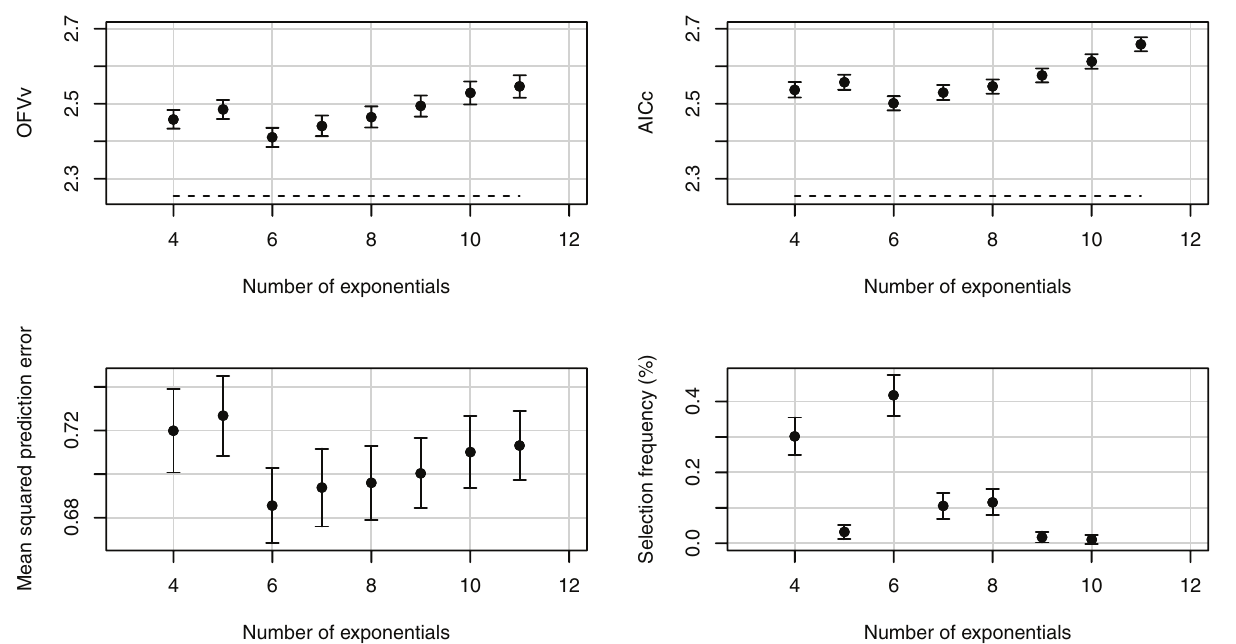
Figure 4. Mean OFV , AIC , prediction error ν 2 , and model selection frequencies as a function of the number of exponentials, for ω 2 = 0.1; v c parameters otherwise identical to those for Figure